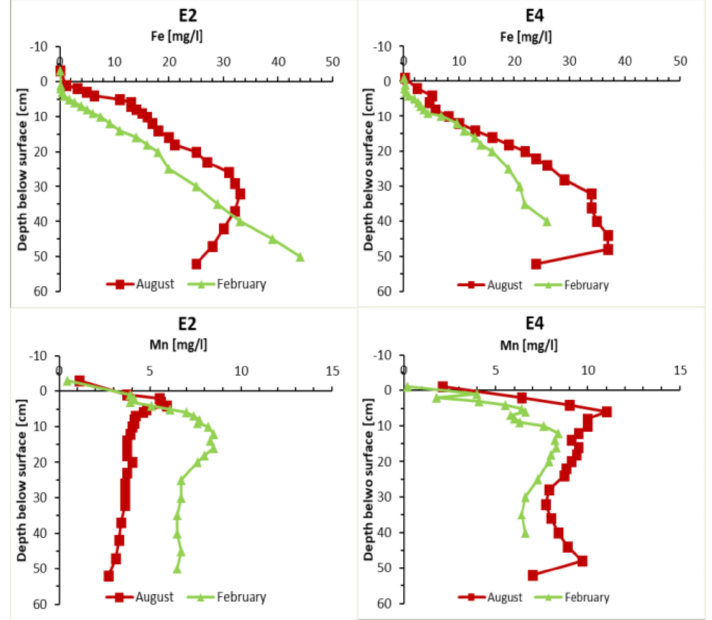
Figure 10. Iron (Fe) and manganese (Mn) pore water profiles at locations E2 and E4 determined in August 2018 and February 2019.